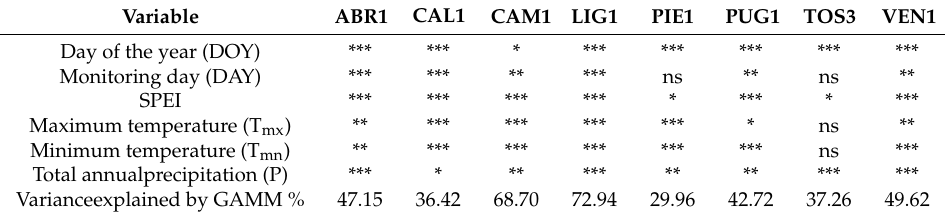
Table 6. Statistical significance of predictors included in the GAMM used to fit tree-level inter-annual growth in relation to the climatic variables with tree identity as a random factor. The statistical significance was tested according to the following thresholds: *** p < 0.001; ** p < 0.01; * p < 0.05; ns p ≥